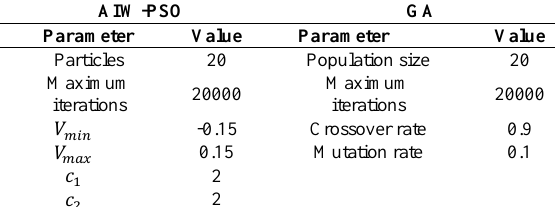
Table 4. Values of the parameters for the chaotic AIW-PSO and GA. AIW-PSO